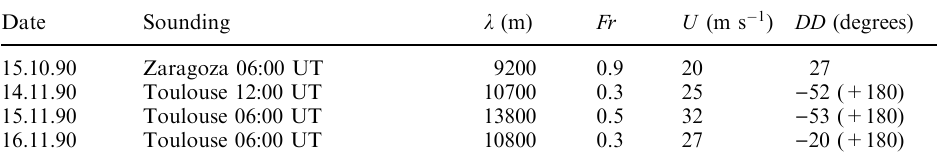
Table 1. Upstream characteristics deduced from radiosonde soundings: Brunt Va¨ isa¨ la¨ wavelength ( (cid:107) ), Froude number ( Fr ), speed of horizontal wind vector ( U ) and its angle with the cross-chain axis ( DD ) (the sign is positive in the clockwise sense). The values were computed in the 3000–6000 m altitude range except for Fr computed in 0–3000 m range and DD measured at about 3000 m